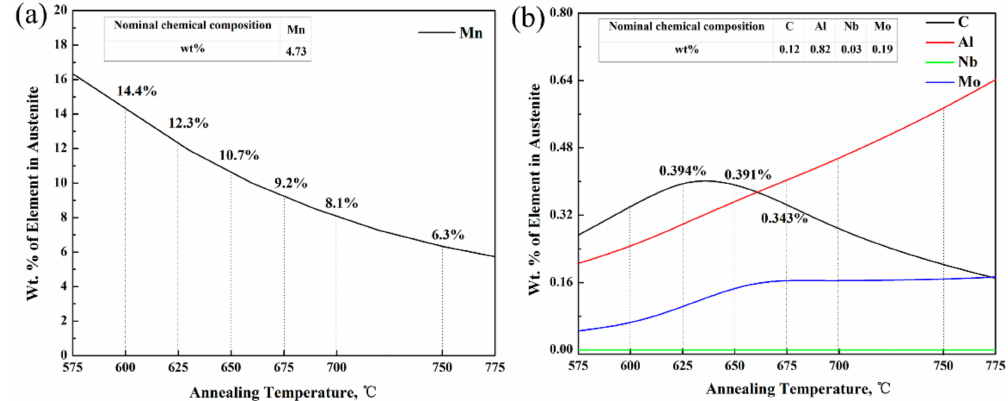
Figure 5. Calculated weight percent of Mn, C, Al, Mo, and Nb in austenite by Thermo-Calc. ( a ) Mn, ( b ) C, Al, Mo, and Nb in austenite by